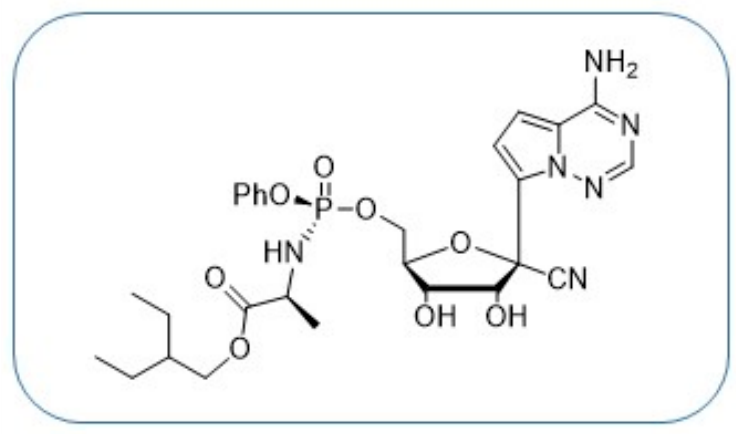
Figure 1. Remdesivir, long synthesis, poor PK, moderate antiviral activity. Remdesivir is active against several RNA viruses, including coronaviruses and Ebola virus [2]. Remdesivir is an adenosine analogue, a C -nucleoside with a 5 (cid:48) -phosphate pro- drug and a cyano group at the 1 (cid:48) position of the carbohydrate moiety. In infected cells, Remdesivir is converted to the corresponding triphosphate form, which acts as a